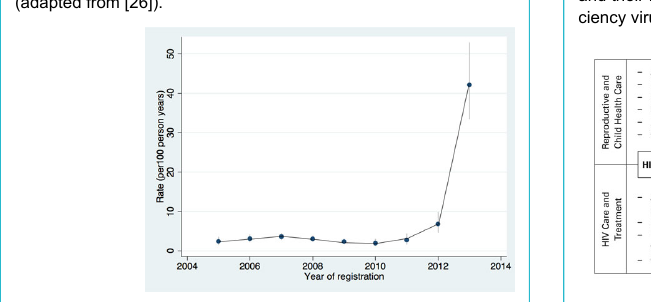
Figure 3: Incidence rate of tuberculosis ascertainment before and after the integration of HIV and tuberculosis services in 2013 (adapted from [26]).